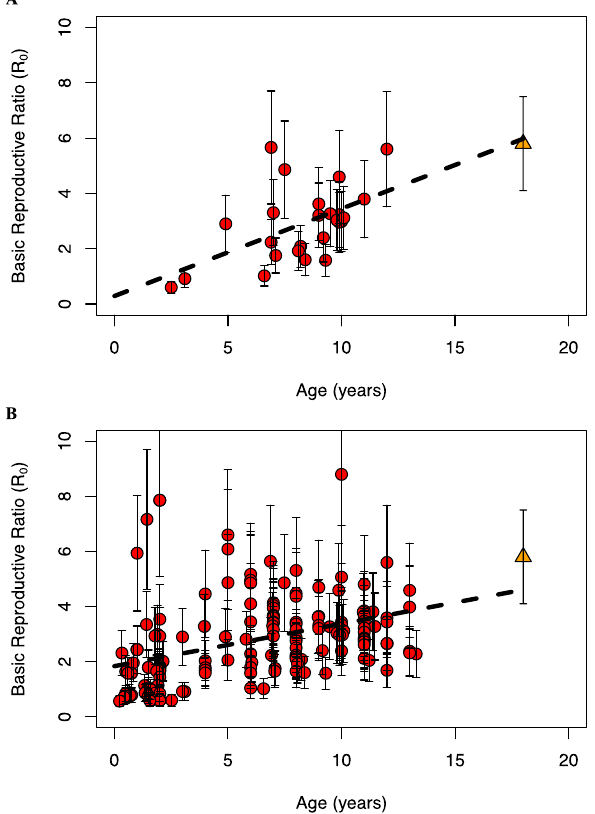
Figure 3. Dependence of R 0 on age. ( A ) Estimates of R 0 for the children analyzed using the mathematical model of viral dynamics (n = 25, listed in Table 1). ( B ) Approximate estimates of R 0 from all children with baseline CD4 T cell counts above 100 cells/µL (n = 157, see text). Red circles indicate the mean R 0 for an individual. Error bars represent R 0 estimated using CD4 T cell counts 1 SD above and below the mean, measured in healthy Indian individuals 21 . The orange triangle is the mean R 0 for HIV-1C in Indian adults estimated previously 15 . Error bar represents the standard deviation. Dashed line is the best-fit line. Pearson ρ = 0.53 ( P = 0.006) in ( A ) and Pearson ρ = 0.38 ( P = 9.1 × 10 –7 ) in ( B